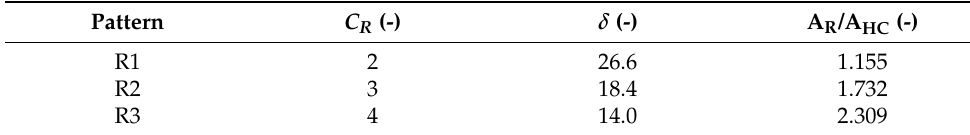
Table 3. Rhomboidal pattern design: rhombus diagonal ratio C R , half of rhombus minor angle δ ,